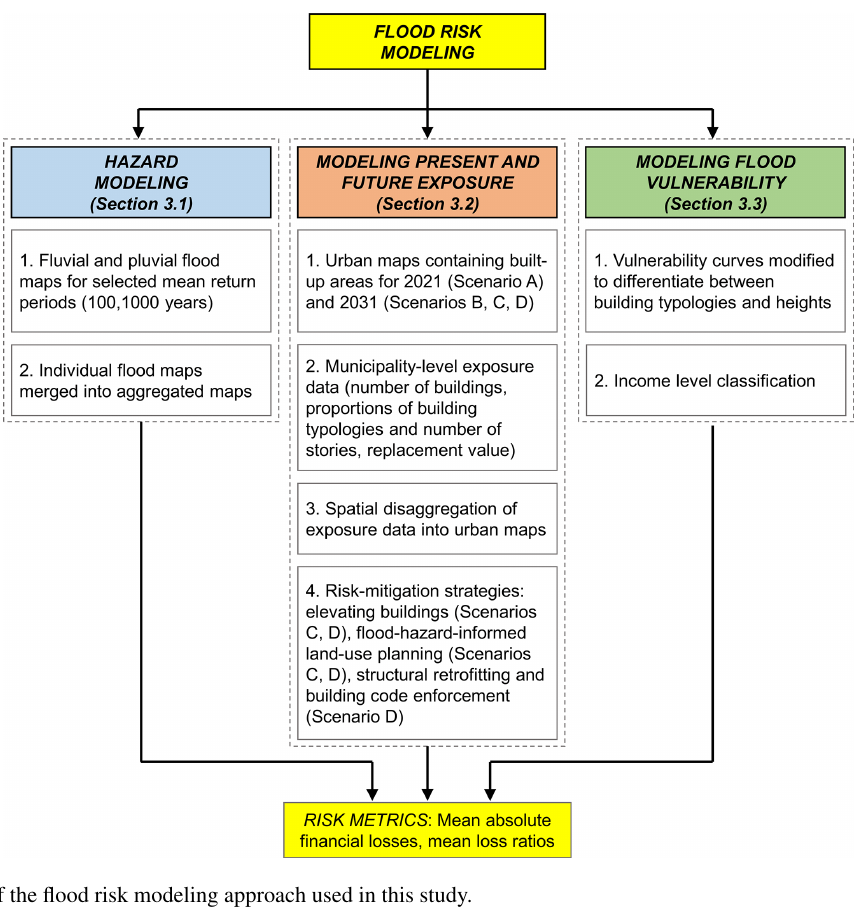
Figure 3. Overview of the flood risk modeling approach used in this study.